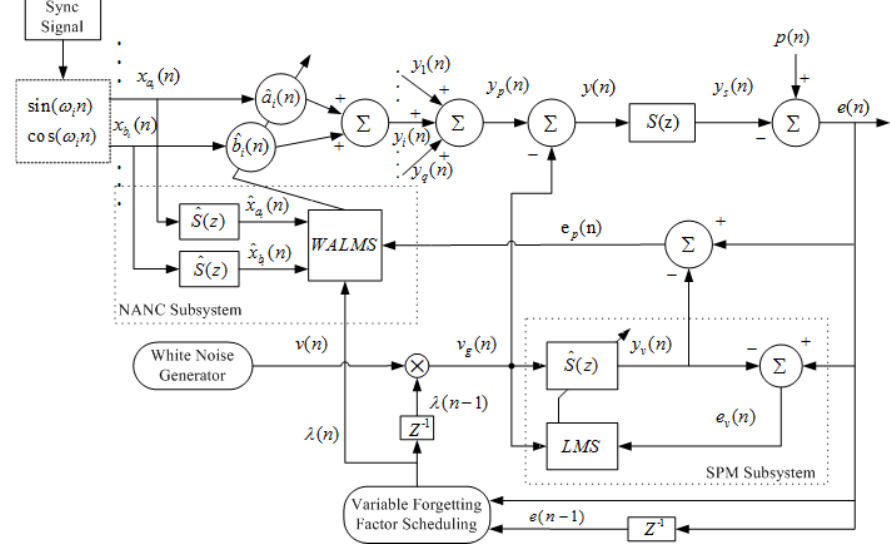
Figure 3. NANC system with online SPM using new auxiliary noise power scheduling strategy ( i th